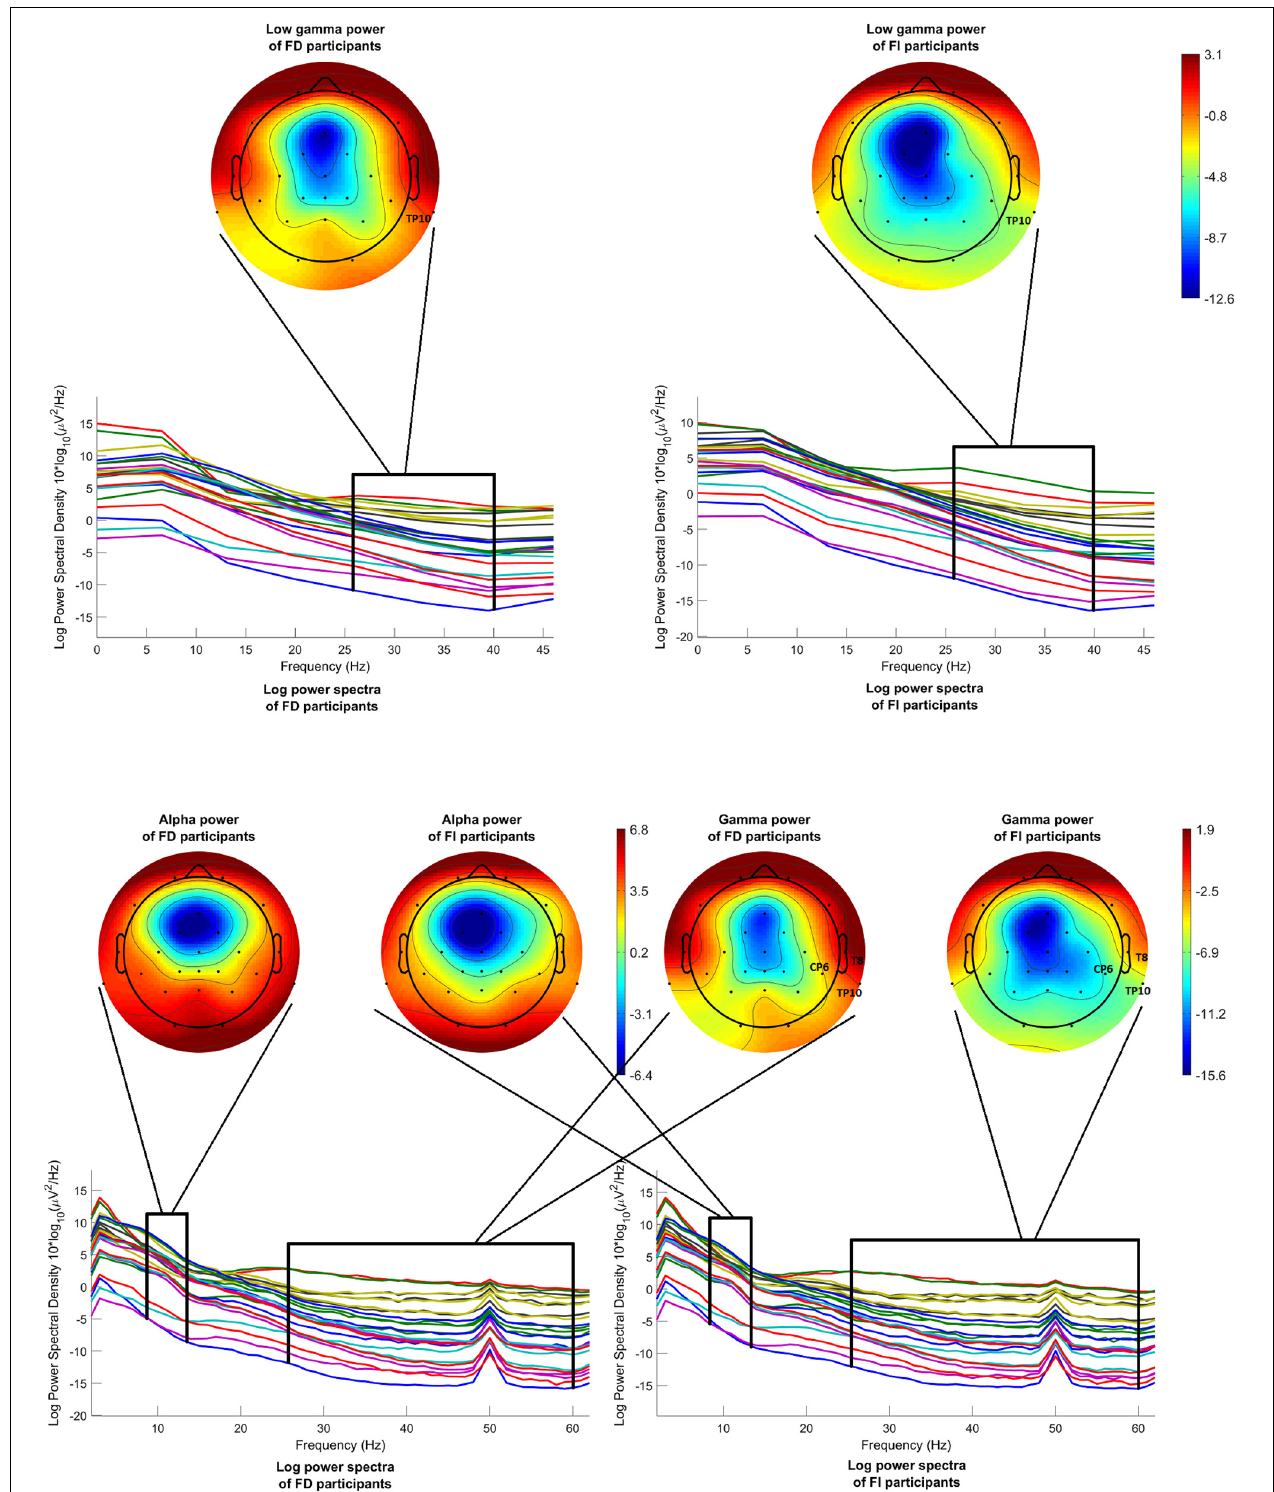
FIGURE 7 | Mean log power spectra over FD and FI participants, in the interval [–200 –50]ms before onset, for each channel and for condition c1 and respective scalp maps after averaging over the low gamma band (26–40 Hz) (above). Mean log power spectra over FD and FI participants, in the interval [–1000 0]ms before 2nd button, for each channel and for condition c1 and respective scalp maps after averaging over the alpha band (8–13 Hz) ( on the left ) and over the gamma band (26–60 Hz) ( on the right ). The labels of the channels indicate the locations where the difference passed the threshold.